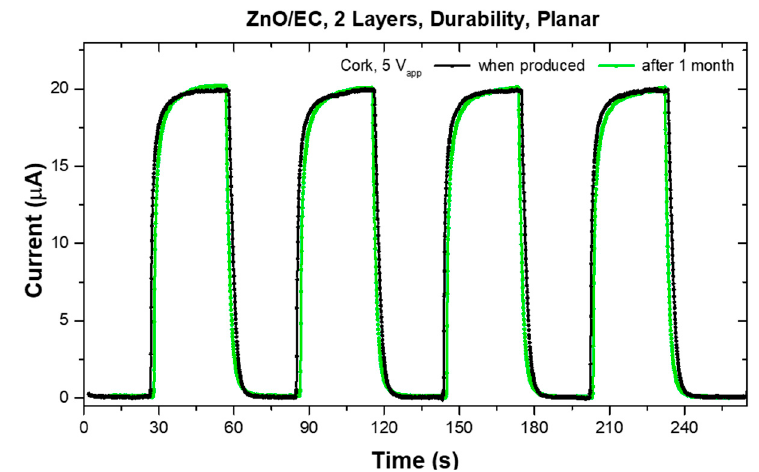
Figure 6. Photoresponse of a cork sensor over time, right after being produced and then after one month of being stored in the lab (23 º C and 30% RH).